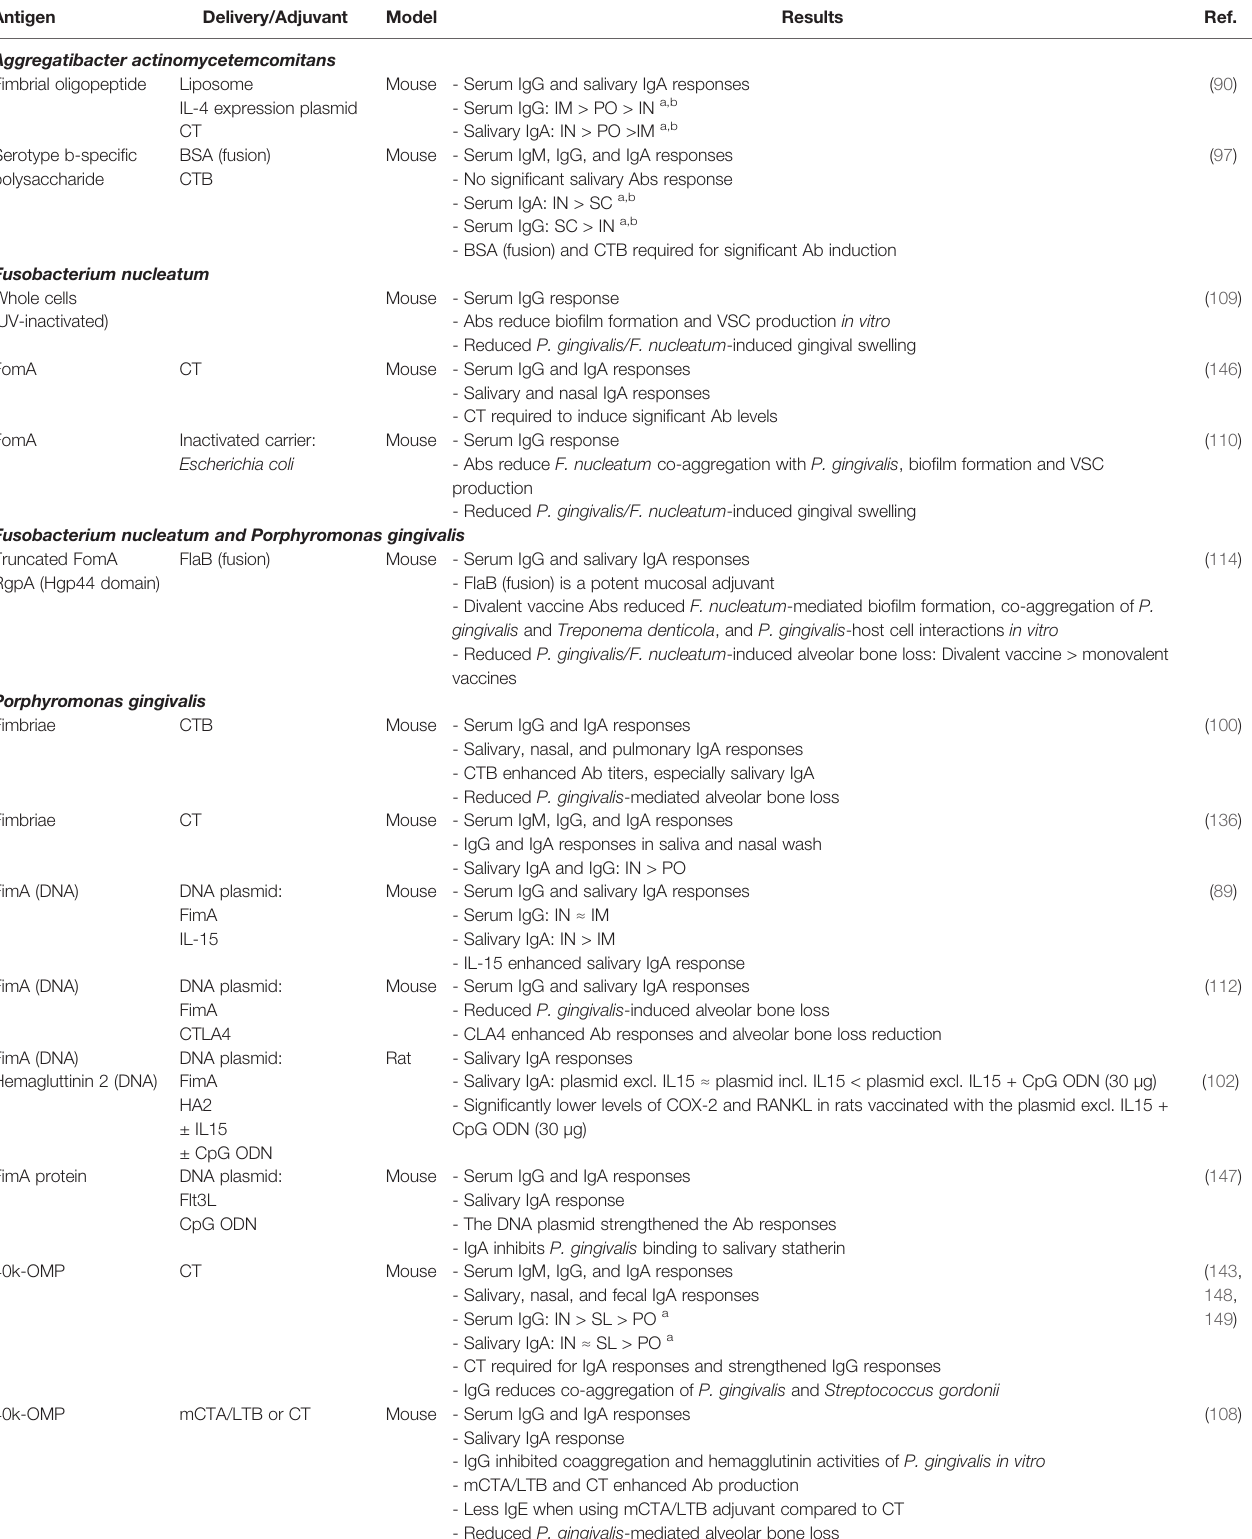
TABLE 2 | Preclinical development of intranasal vaccines against periodontal disease, organized per target pathogen. Antigen Delivery/Adjuvant Model Results